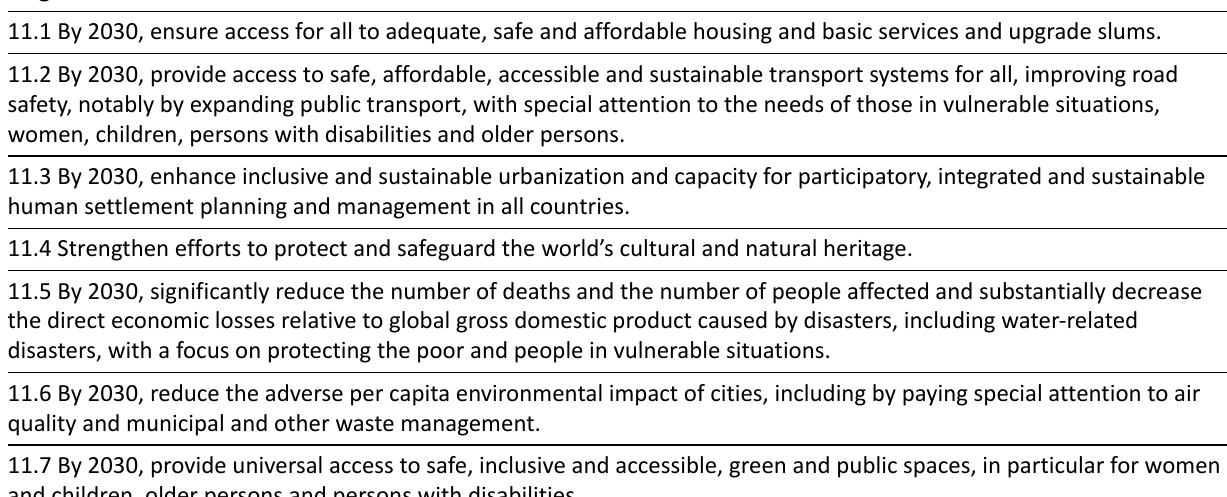
Table 1. Indicators used in analysis of Goal 11: “Make cities and human settlements inclusive, safe, resilient and sustain- able”. Source: compiled based on UN SDGs indicators.